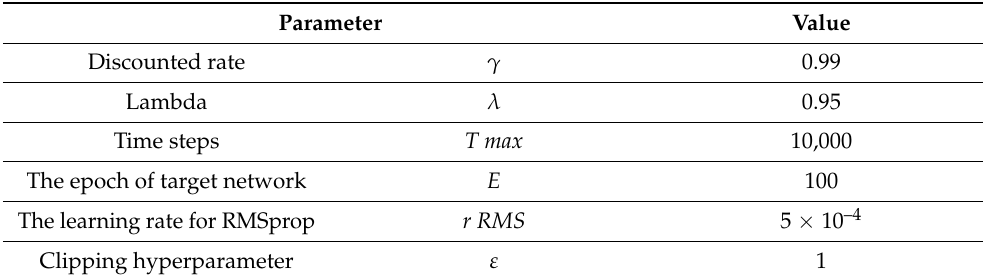
Figure 9. QMIX algorithm for the multi-ship collision avoidance. Table 3. The parameters of the training